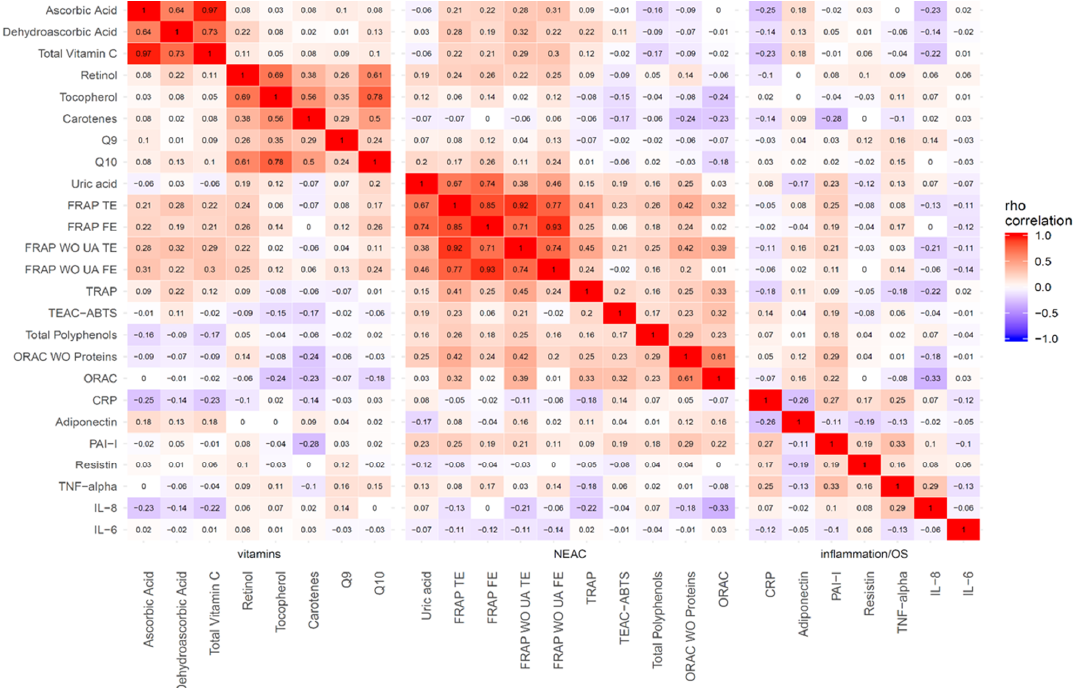
Figure 1. Correlation matrix between biomarkers depicted as a heatmap. (Heat map represents the color-coded correlation factors between all biomarkers including levels of P-NEAC, nutrient antioxidants and biomarkers of inflammation in the EPIC Granada-Gipuzkoa study. The color value of the cells is proportional to the strength of the associations, ranging from red (positive correlations) to blue (negative correlations). The strength of the correlation is indicated in the color scale (at the right of the panel). Pair-wise spearman correlation coefficients (rho) are shown in every cell. Abbreviations: WO = without; UA = uric acid; OS = oxidative stress.